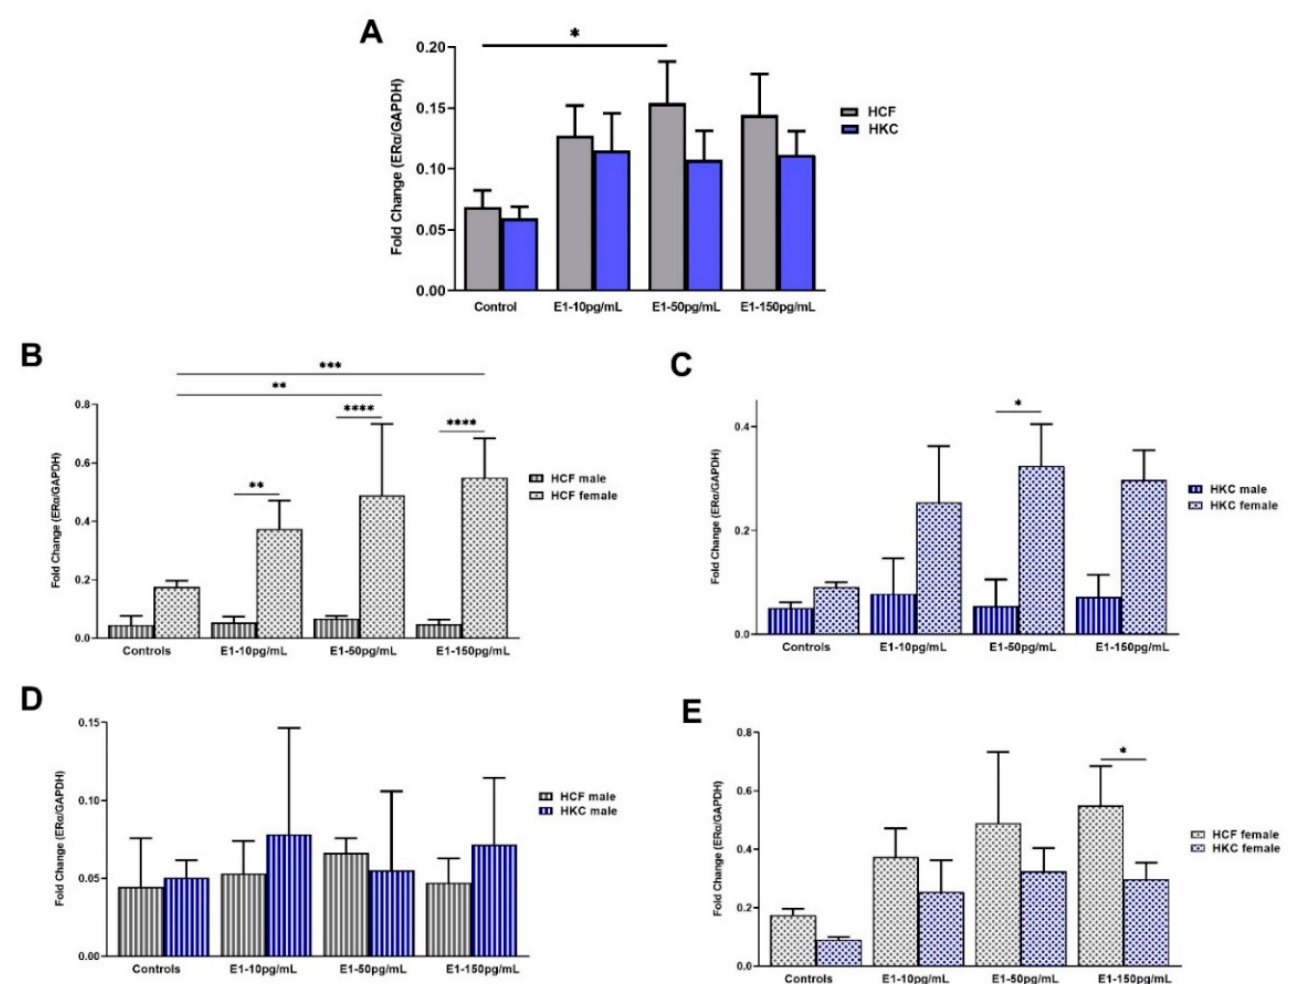
Figure 3. Expression of ER α in 3D HCFs and HKCs in response to 10, 50, 150 pg/mL E1 stimulation for four weeks. ( A ) Overall ER α expression in HCFs and HKCs ( n = 6). ( B ) Sex-specific expression of ER α in HCFs ( n = 3). ( C ) Sex-specific ER α expression in HKCs ( n = 3). ( D ) Male-specific ER α expression in HCFs vs. HKCs ( n = 3). ( E ) Female-specific expression of ER α in HCFs vs. HKCs. * p < 0.05, ** p < 0.01, *** p < 0.001, and **** p < 0.0001.